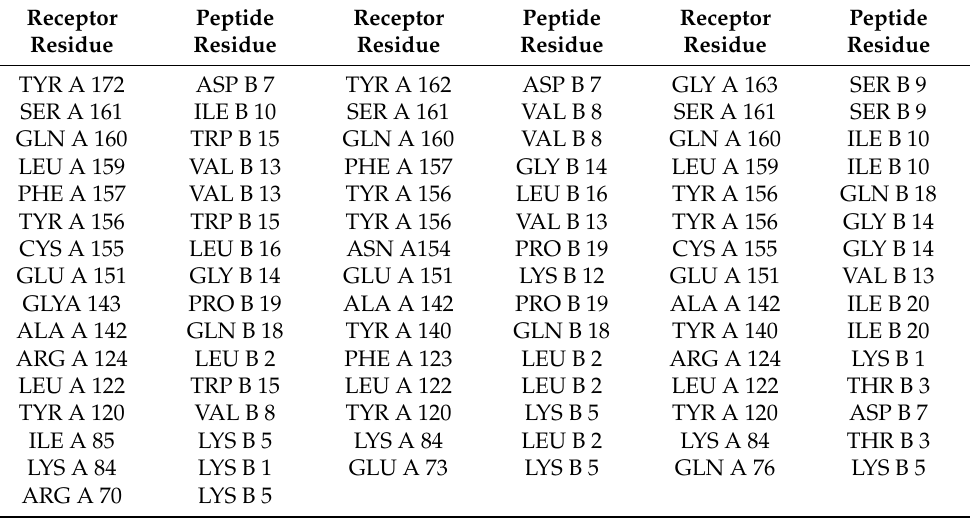
Table A3. Sense-antisense pairs of peptide/receptor residuals closer than 4.5 Å in the selected com- plex using CABS-dock method [28]. Antisense peptide sequence was KLTIKGDVSIPKVGWLPQPIV, and the receptor sense region was aa 334–523 of RBD S1